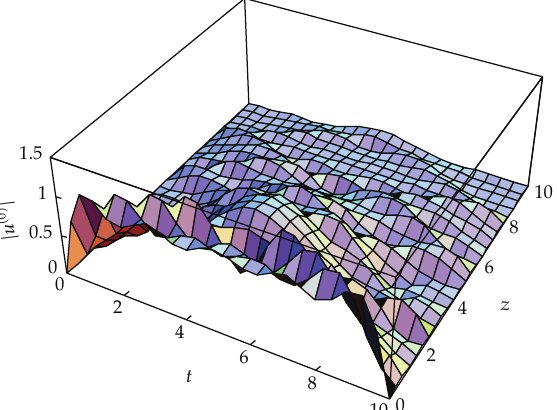
Figure 4: The zero-order approximation of | u (cid:3) 0 (cid:4) | at α (cid:8) 1, T (cid:8) 10, γ (cid:8) 02 with considering only one term in the series (cid:3) M (cid:8) 1 (cid:4)